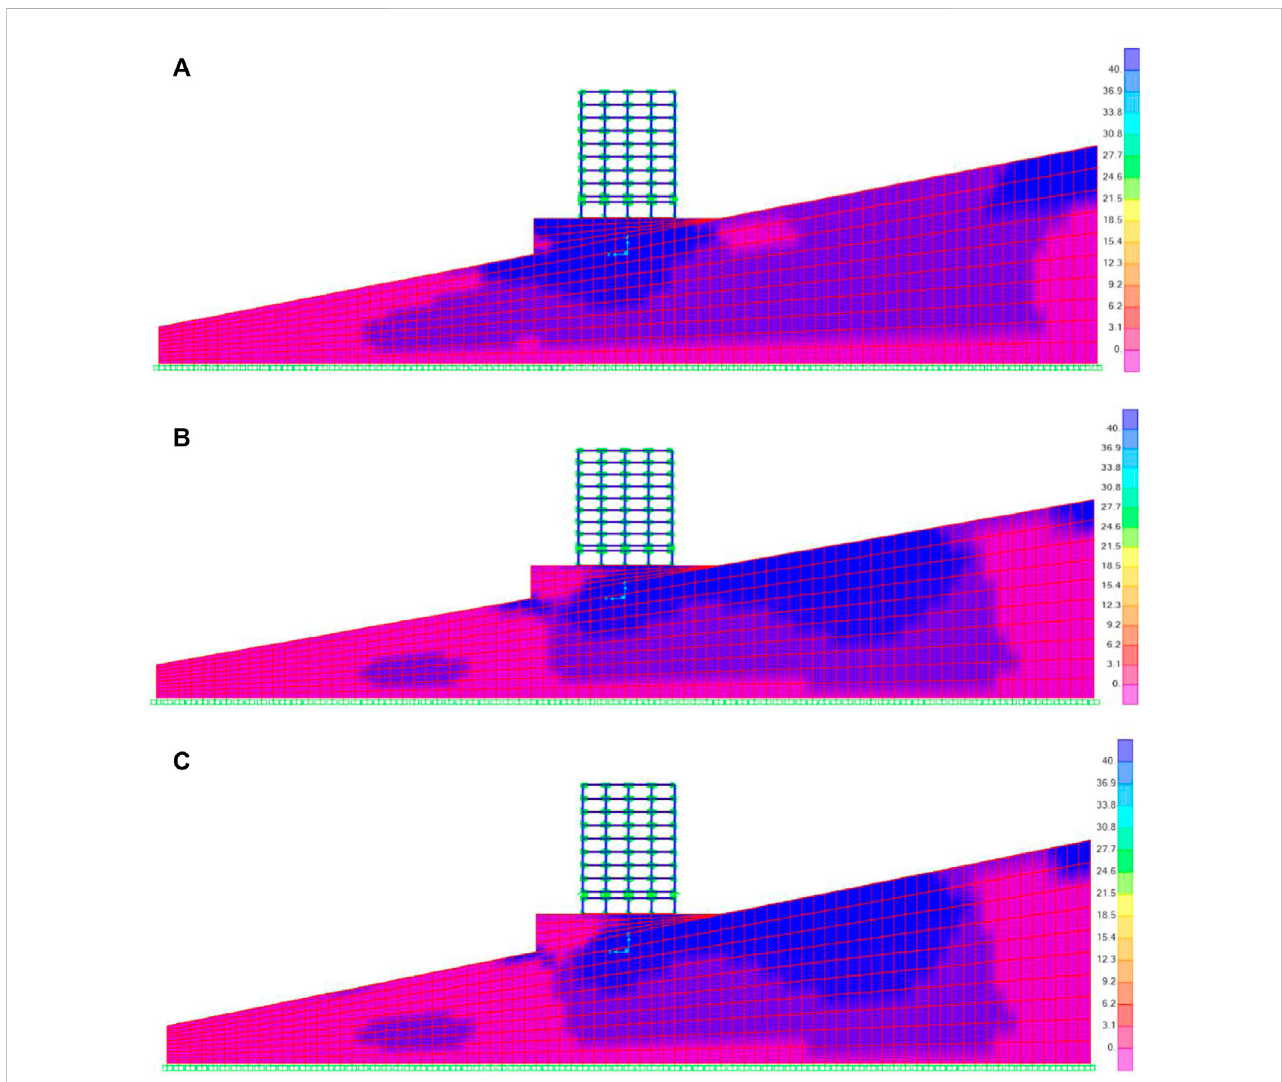
FIGURE 12 Stress of the soil foundation (N/m 2 ). (A) Traditional 2D mid-story-isolated structure. (B) 3D LRB mid-story-isolated structure. (C) 3D T/C FPB mid-story- isolated structure.